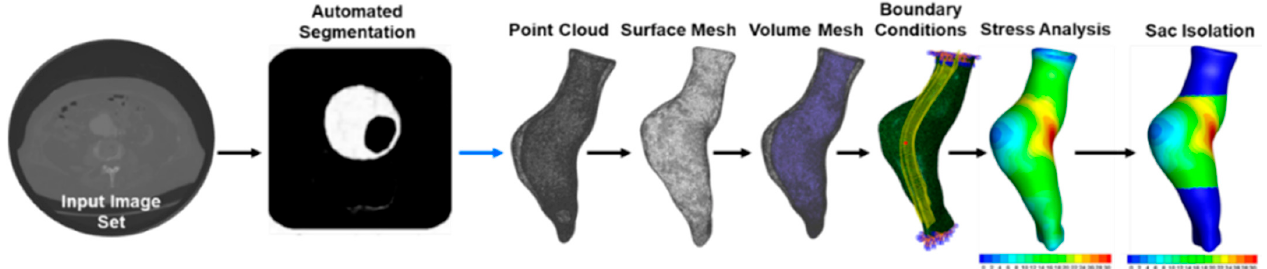
Figure 1. Image segmentation pipeline utilizing an automated segmentation technique based on a U-NET convolutional neural network. After the initial segmentation is accurately performed, the automated pipeline creates a finite element model by converting the point clouds into a mesh, assigning boundary conditions, performing FEA, and post-processing for aneurysm sac isolation.